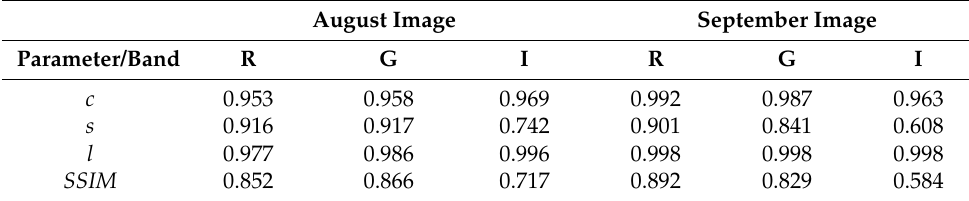
Table 4. Similarity between homogenized drone images. Reference: July image.